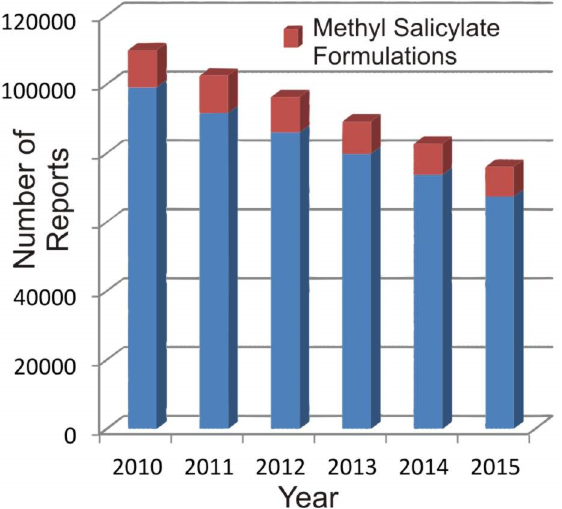
Figure 1. Annual case reports of suspected/potential poisoning due to the use of topical agents. Data extracted from the American Association of Poison Control Centres’ National Poison Data System